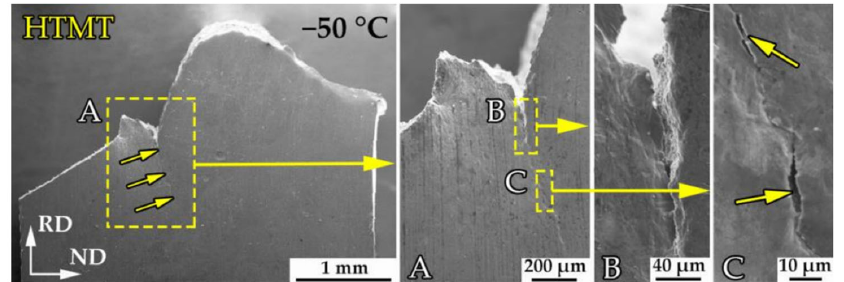
Figure 14. SEM images of the lateral surface of the impact sample after HTMT tested at − 50 ℃ . A, B, C—magnified images of the areas outlined by dashed frames.